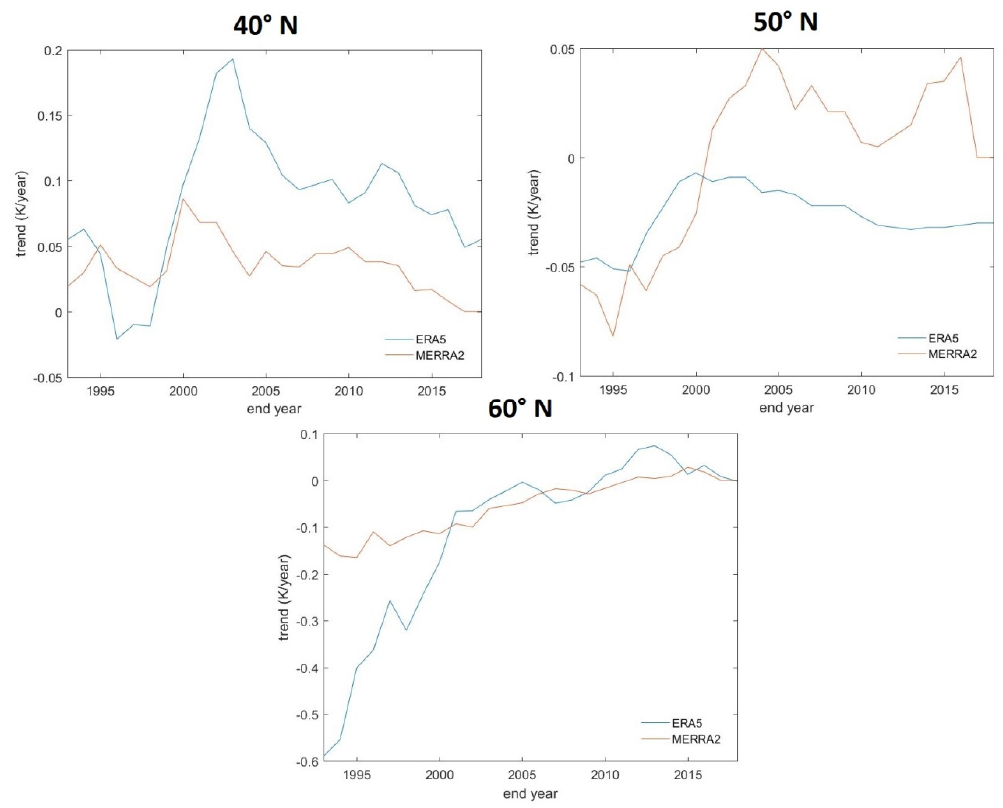
Figure 7. Temperature trend (K/dec) for MERRA and ERA5 reanalysis in January at 10 hPa for 40° N, 50° N, and 60° N. Trend is calculated for the period from 1980 to 1993–2018 (length of the period varies).